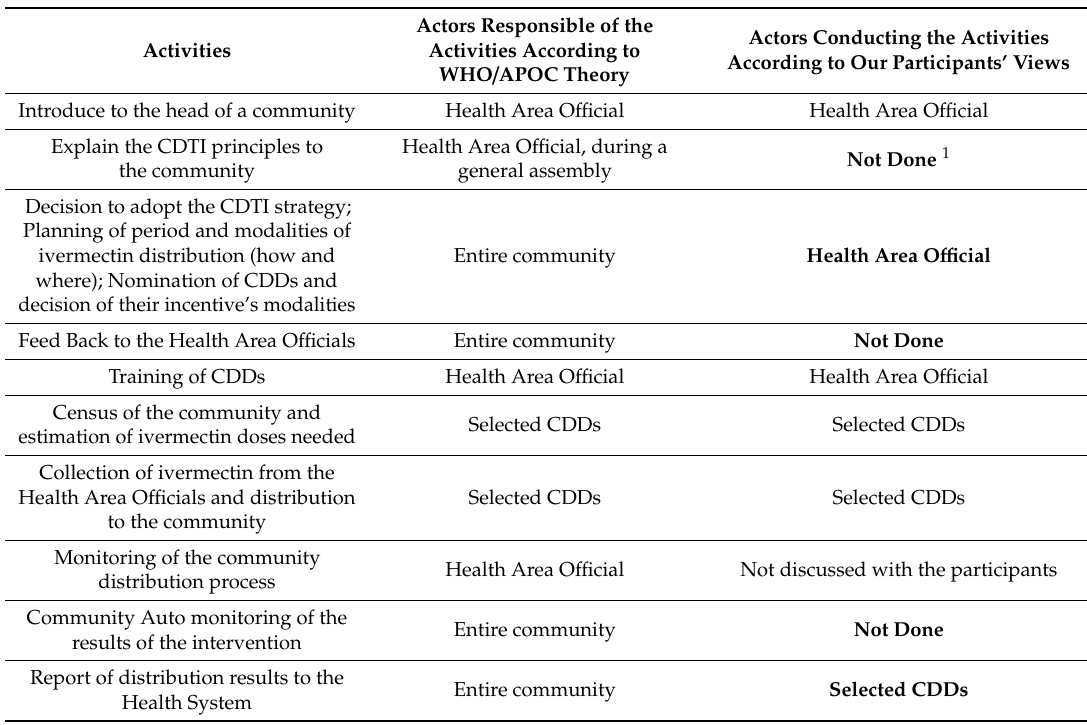
Comparison of roles distribution in the CDTI between WHO / APOC theory and communities’